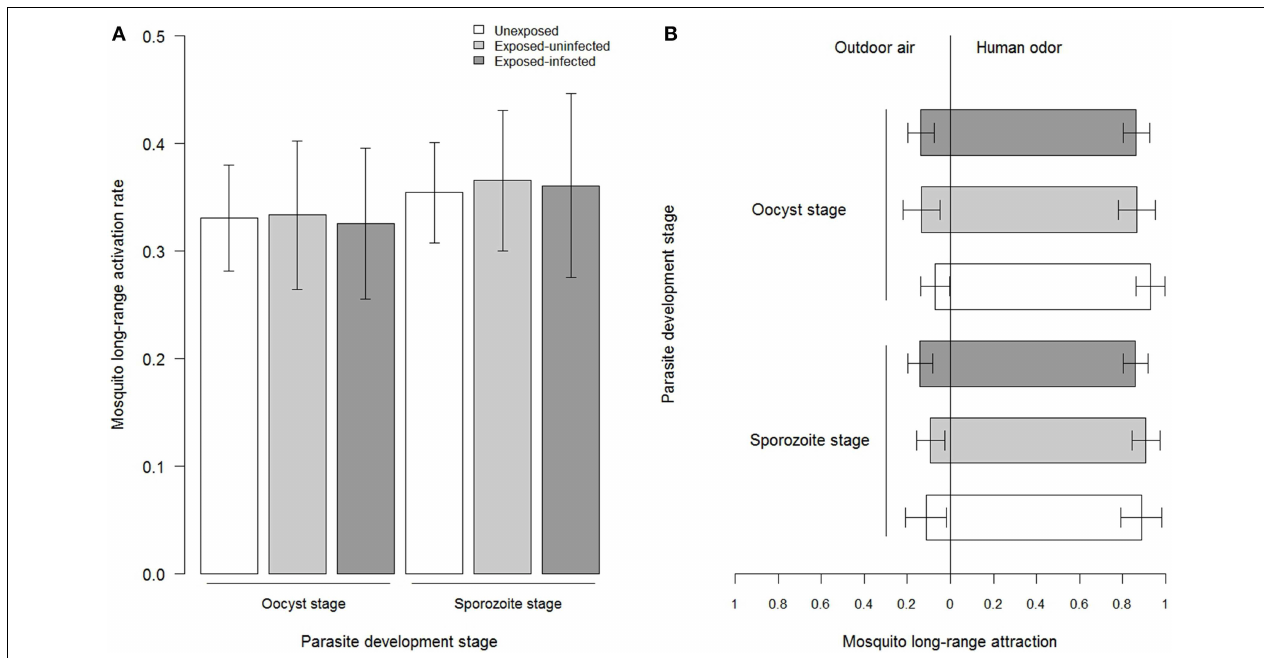
number retrieved from both collecting boxes for each parasite stage and for the three mosquito’s infection status. The oocyst stage corresponds to tests carried out from 6 to 8 days post-infectious blood-meal and the sporozoite stage corresponds to tests carried out from 13 to 17 days post-blood meal. Error bars show the 95% confidence